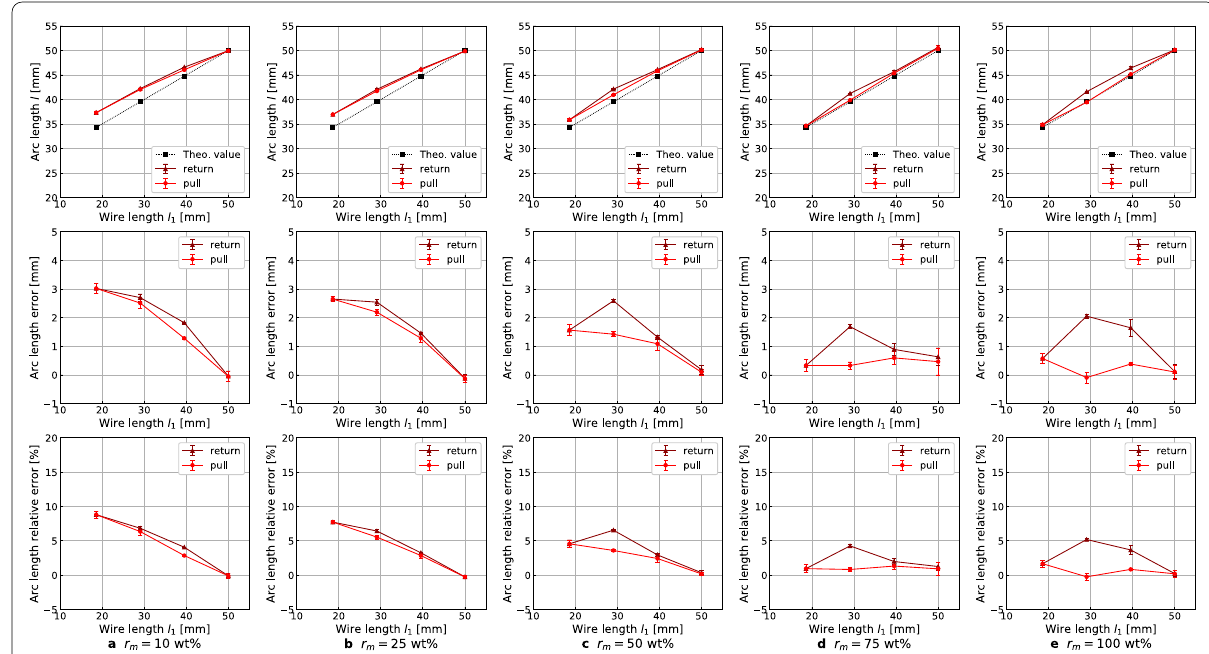
Fig. 9 Neutral arc length l (top), its error (middle), and relative error (bottom) to wire length l 1 for each plasticizer mixing ratio in deformation pattern (a). Each plot represents the mean value of the three times. The error bars represent the standard